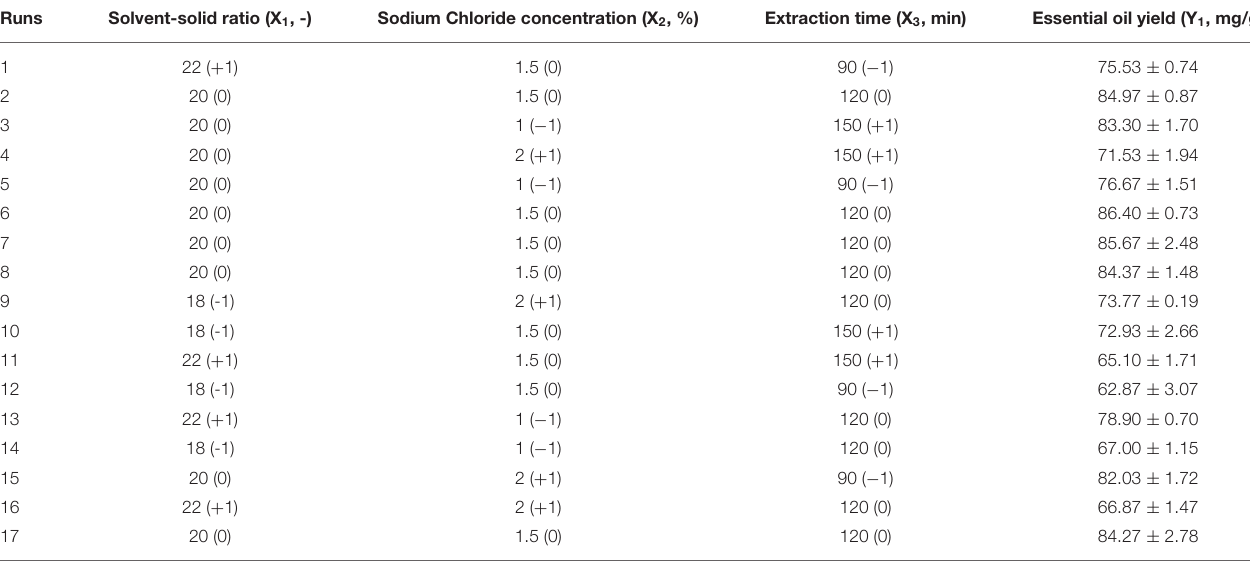
TABLE 1 | Box-Behnken experimental design matrix with experimental response for TCEO using traditional hydrodistillation extraction. Runs Solvent-solid ratio (X 1 ,